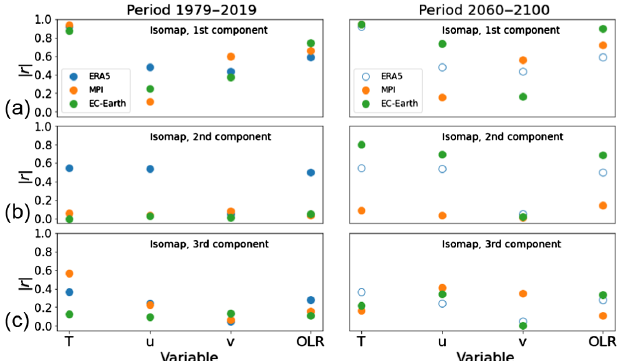
FIG. 4. (a) Correlations (in absolute value) between the first Isomap component of each variable (on the x axis) and the multivariate case in ERA5 and models [signals in Figs. 3(a) – 3(d) for ERA5 and Figs. 18 and 19 for MPI and EC-Earth respec- tively]. Rows (b) and (c) are the same as row (a) but for the second and third Isomap